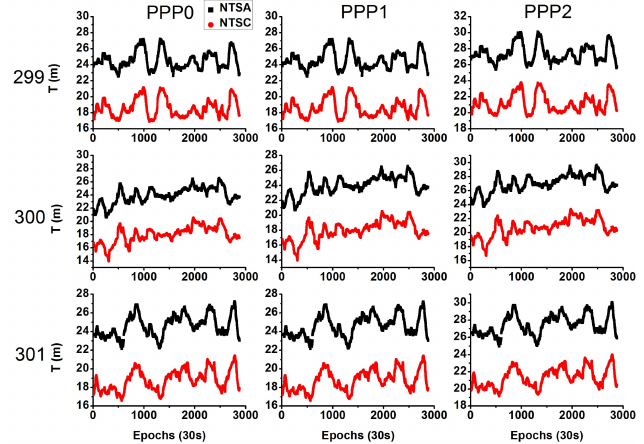
Figure 3. Comparison of clock time series between different solution models (The vertical offset between the NTSA and NTSC clock traces is a system bias related to the hardware delay).